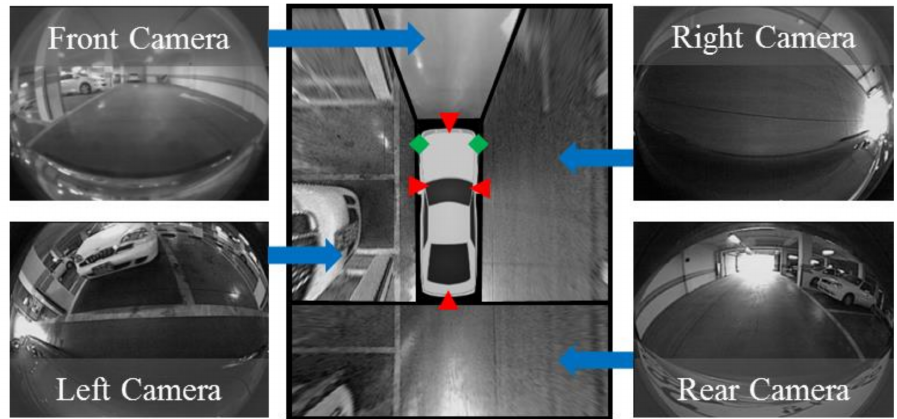
Figure 2. Sensor configuration. Red triangles and green diamonds are four cameras of the AVM system and two ultrasonic sensors,